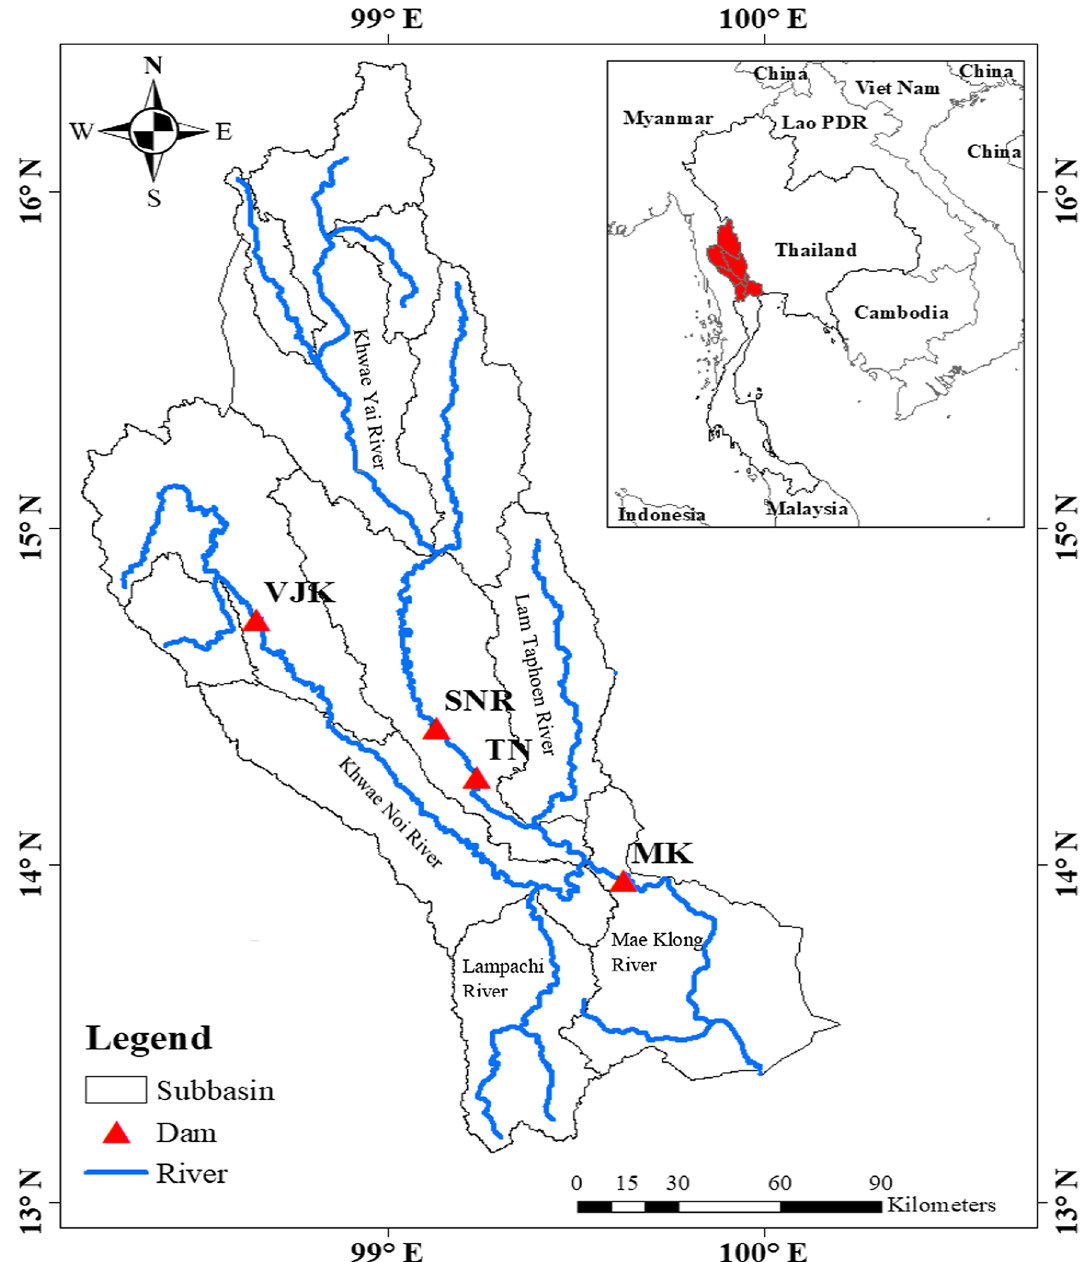
Fig. 1 The Mae Klong River